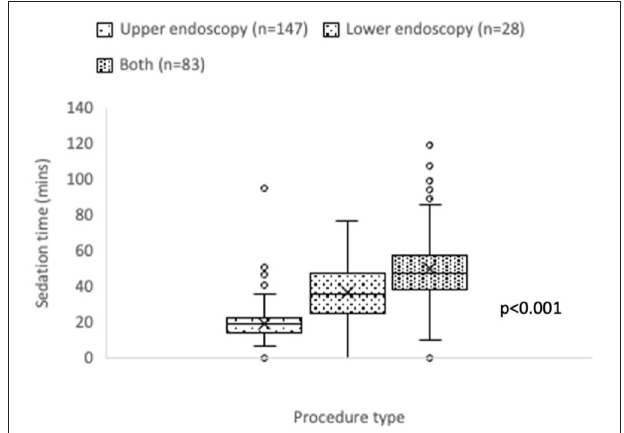
FIGURE 2 | Sedation time (minutes) by procedure